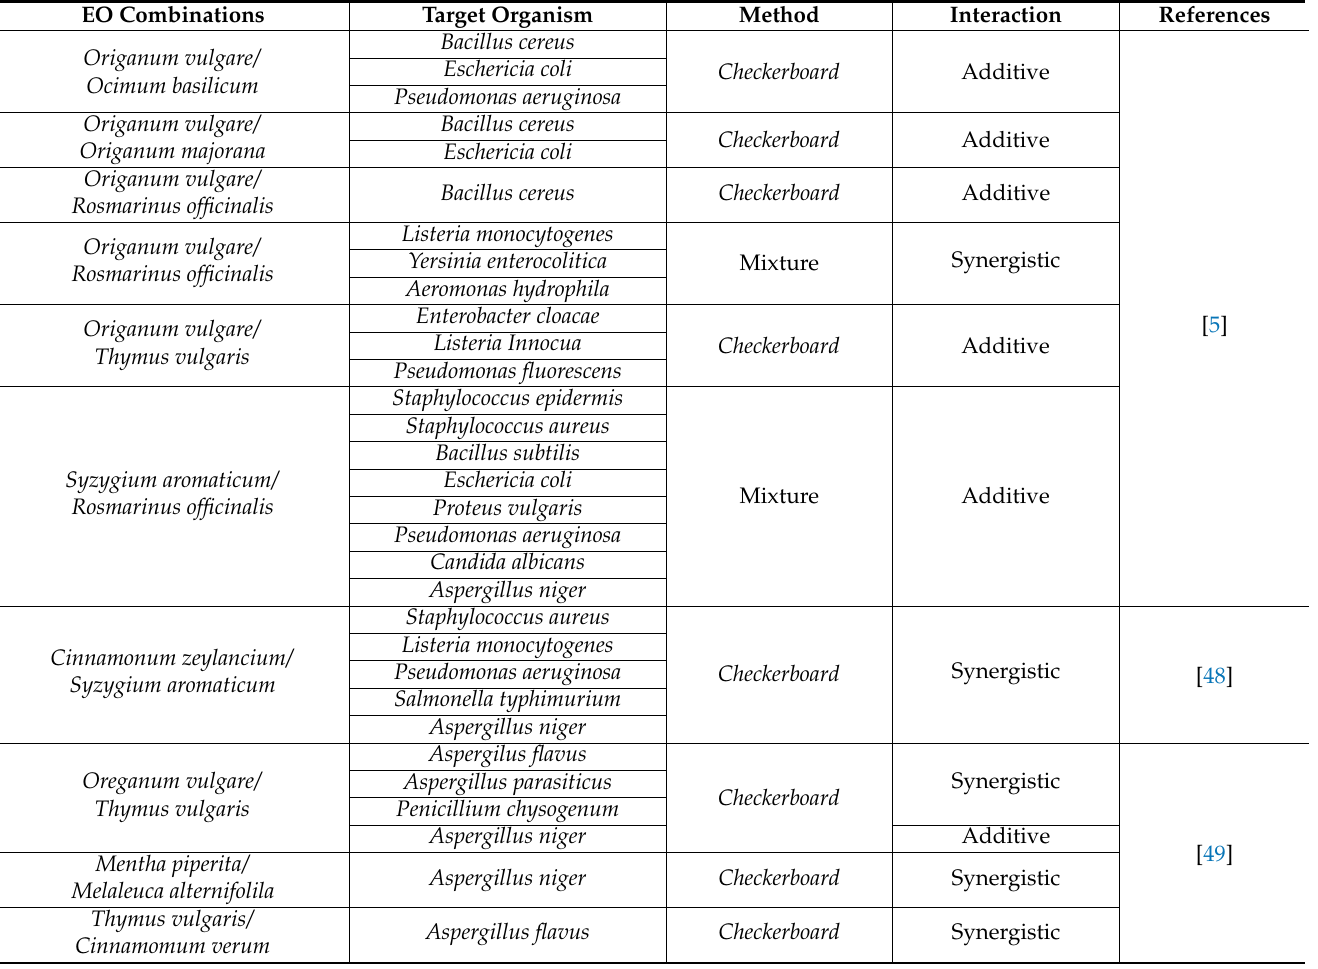
Table 3. Synergistic and additive interactions between EO against micro-organisms (bacteria and